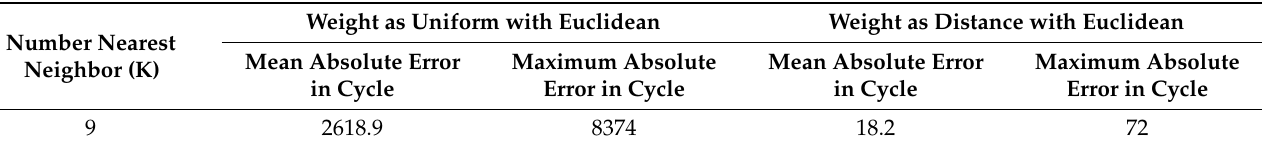
Table 21. KNN result comparison with different weights.